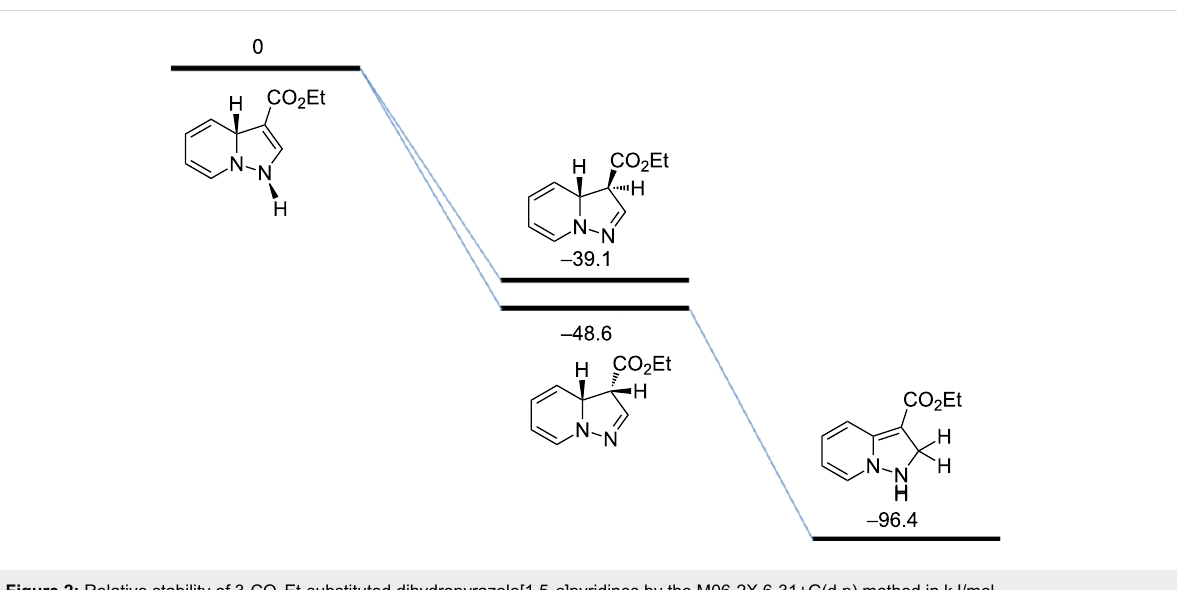
Figure 2: Relative stability of 3-CO 2 Et-substituted dihydropyrazolo[1,5- a ]pyridines by the M06-2X 6-31+G(d,p) method in kJ/mol.